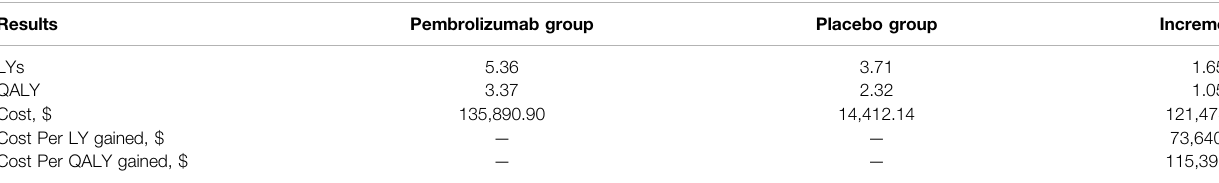
TABLE 2 | Base case results.